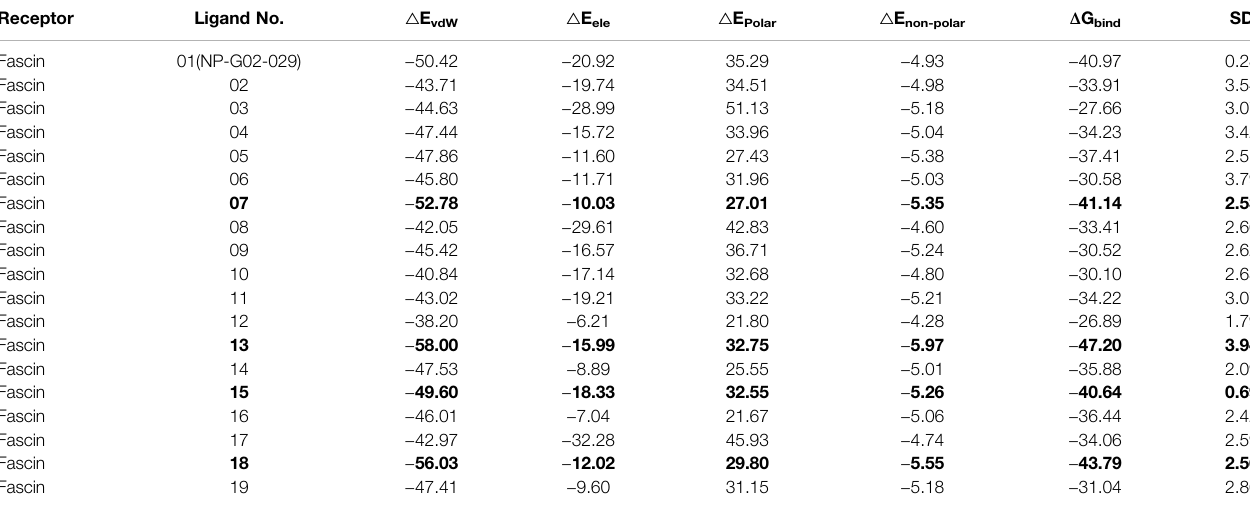
TABLE 2 | Binding af fi nity for each inhibitor by MM/GBSA (Unit: kcal/mol. Potential inhibitors those meet the criterion are highlighted as bold values.) Receptor Ligand No. △ E vdW △ E